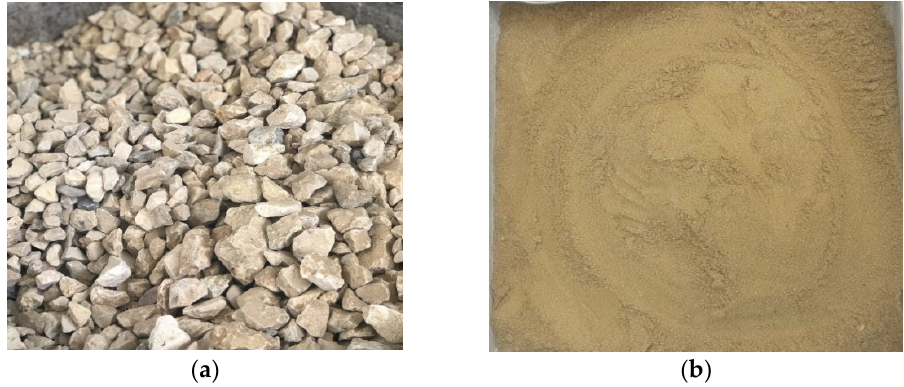
Figure 2. ( a ) Coarse aggregate; ( b ) fine aggregate. Table 1. Oxide compositions of PC, GGBFS, and CCA. Table 2. Properties of fine and coarse aggregates. Property Fine Aggregate Coarse Aggregate Specific